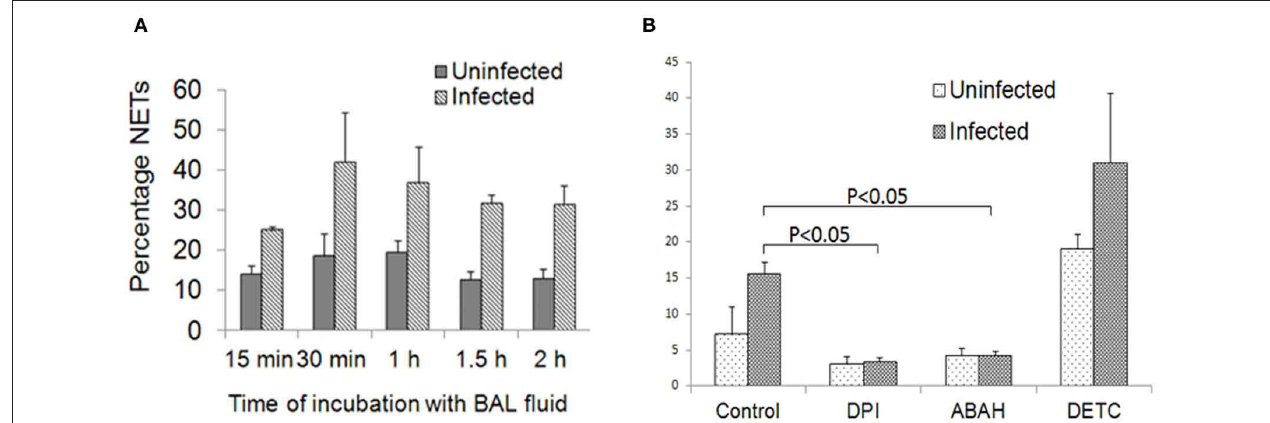
FIGURE 4 | Redox enzymes mediate NETs induction during influenza infection. (A) Neutrophils isolated from bone marrow of uninfected mice produced NETs when stimulated with BALF collected from influenza-infected animals. NETs were identified as early as 30min after incubation. The P -values for the various time-points were